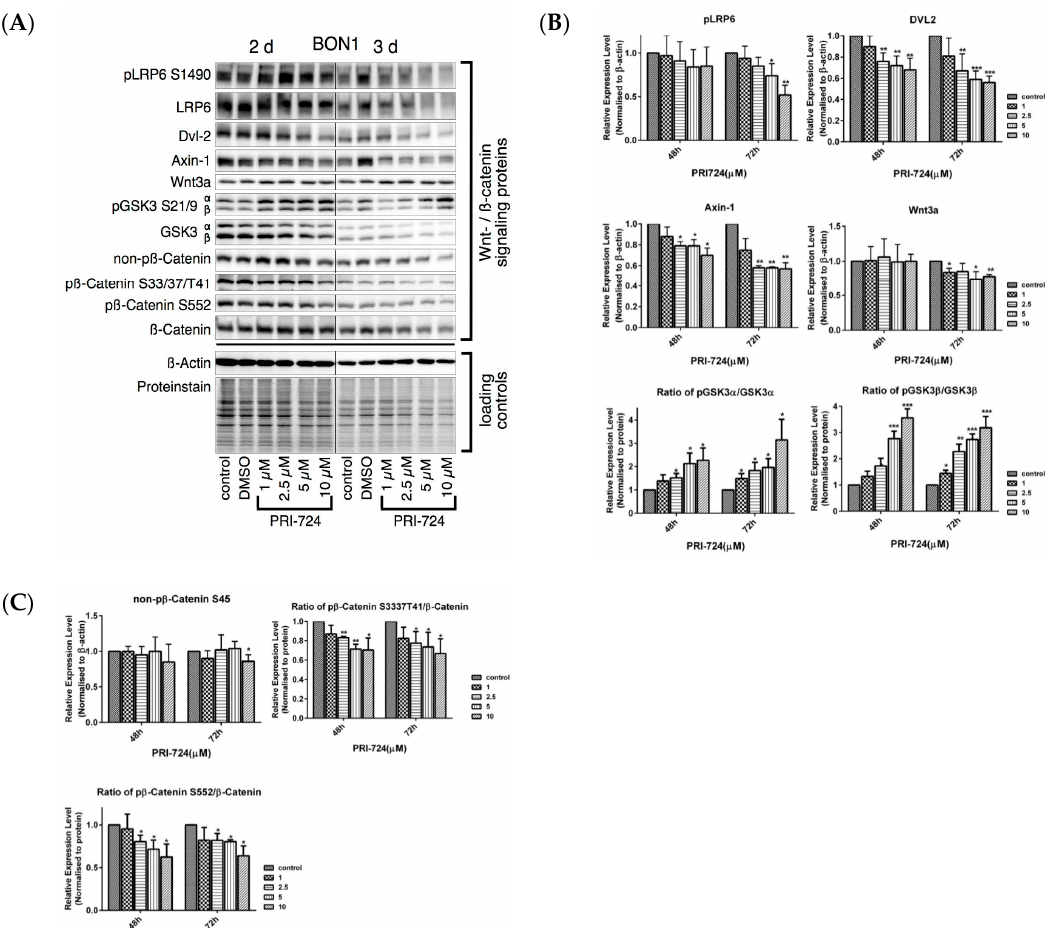
Figure 8. E ff ect of PRI-724 on protein expression levels of Wnt / β -catenin signaling proteins. BON1 cells were treated with PRI-724 for 48 h and 72 h and then subjected to Western blot analysis. ( A ) A representative Western blot is shown. Equal protein loading was verified in all Western blots by normalization to the total protein staining and by the housekeeping protein β -actin. ( B , C ) Densitometric quantification of Western blot data was performed. The DMSO control was set as 1.0. Relative expression levels (normalized to DMSO control) of treated cells were calculated in %. * p < 0.05, ** p < 0.01, and *** p < 0.001 compared with that of DMSO controls.